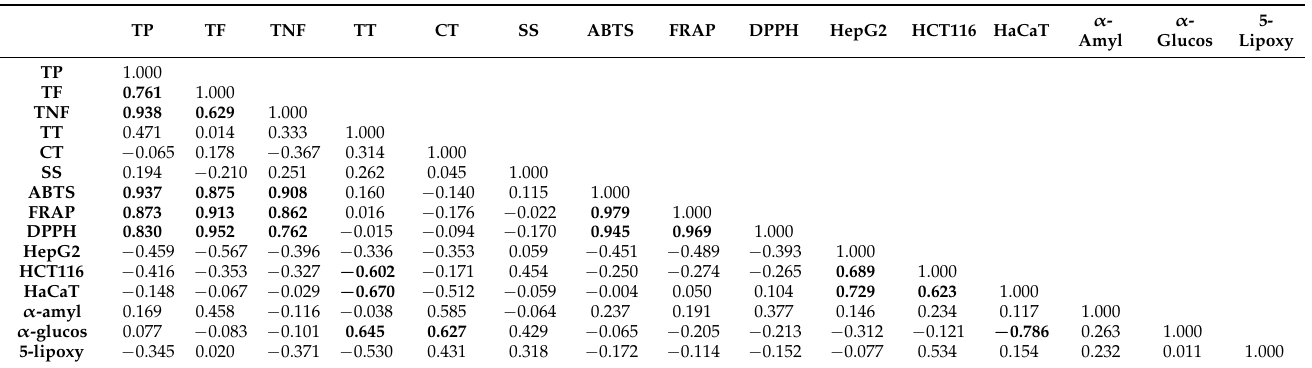
Table 3. Pearson’s correlation coefficient (r) between the groups of metabolites, antioxidant capacity, cytotoxicity, and hypoglycemic and anti-inflammatory potential of Rosaceae